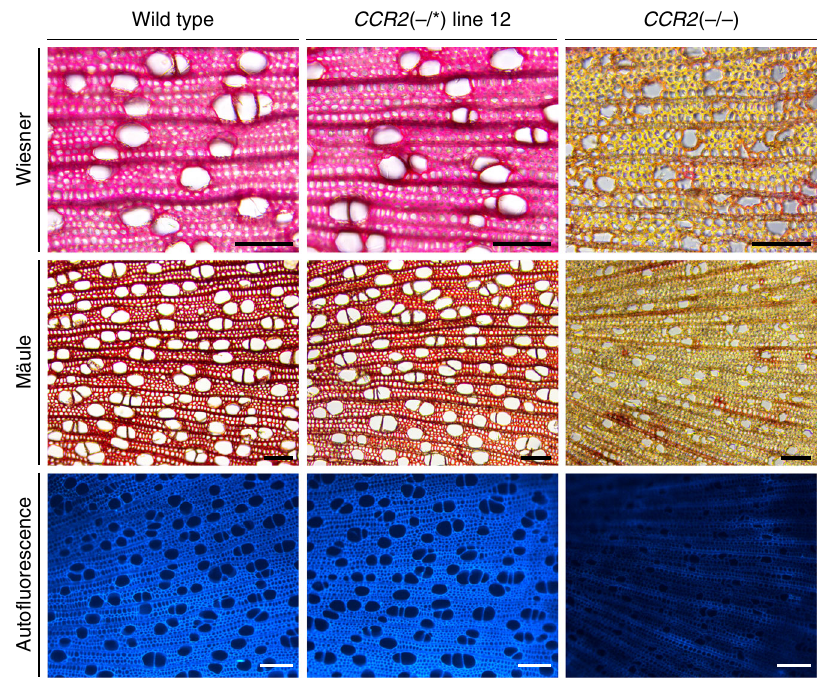
Fig. 3 Xylem morphology in stems of CCR2 ( − /*) line 12 and CCR2 ( − / − ) poplars. Plants were grown for 20 weeks in the greenhouse. Lignin was visualized using Mäule and Wiesner staining and via lignin auto fl uorescence ( λ ex = 365 nm, λ em = 420 – 470 nm). Pictures were taken of the xylem tissue, with the pith localized to the left and the epidermis to the right. Images show representative pictures from fi ve sections per sample and 3 biologically independent samples per line. Scale bar = 100 μ m.